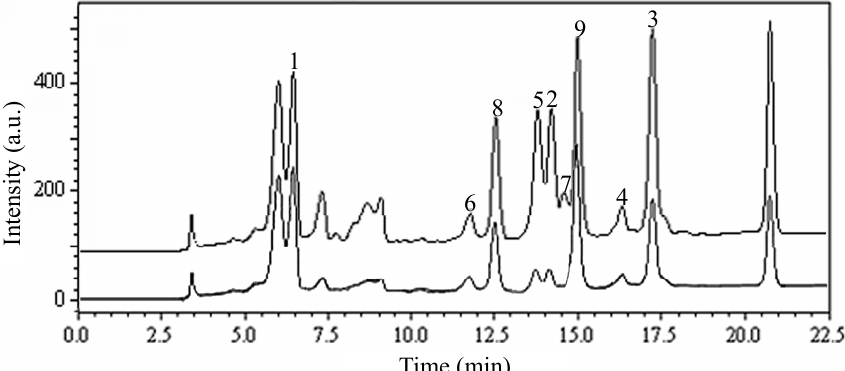
Figure 2. DPPH-HPLC chromatograms of n -butanol extract of Lonicera japonica leaves. Experimental conditions: Shim-pack VP-ODS column (250 mm × 4.6 mm, i.d., 5 µm); Column temperature: 25°C; Flow rate: 1.0 mL/min; Detection: 254 nm; Injection volume: 10 µL. HPLC conditions are as follows: eluent A (MeOH) and eluent B (0.3% acetic acid in water, v / v ), linear gradient combinations: at t = 0, 70% B; at t = 20 min, 40% B; at t = 22.5 min, 40% B. a.u.: arbitrary unit.